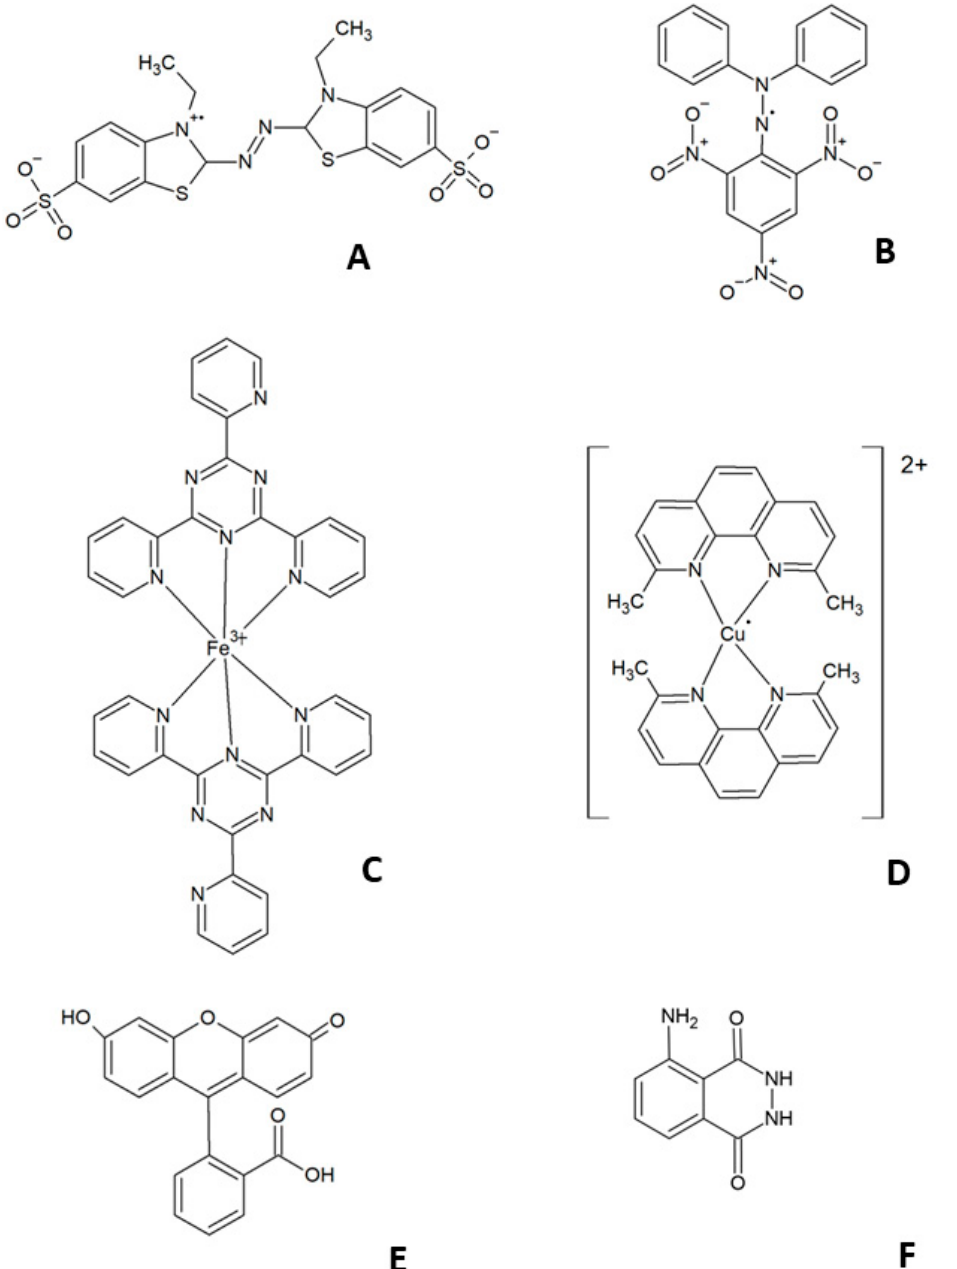
Figure 1. Structure of substrates used in the most popular assays of TAC: ( A ) ABTS • , ( B ) DPPH • , ( C ) bis(TPTZ)Fe 3+ , ( D ) bis(neocuproine)Cu 2+ , ( E ) fluorescein, ( F )